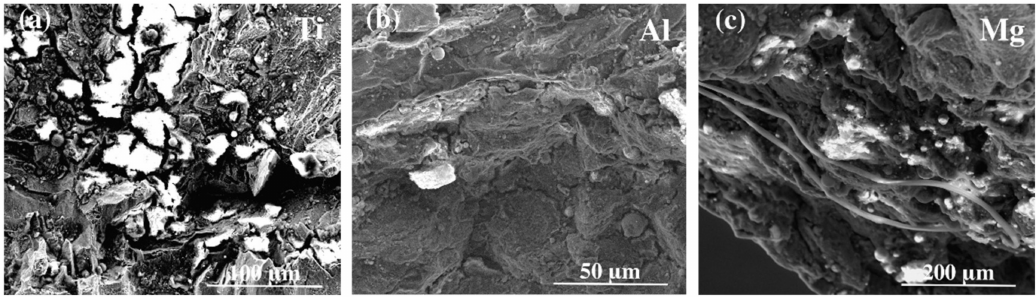
Figure 6. SEM micrographs of the crater for the sample II. ( a ) Ti-matrix; ( b ) Al-matrix; ( c ) Mg-matrix.